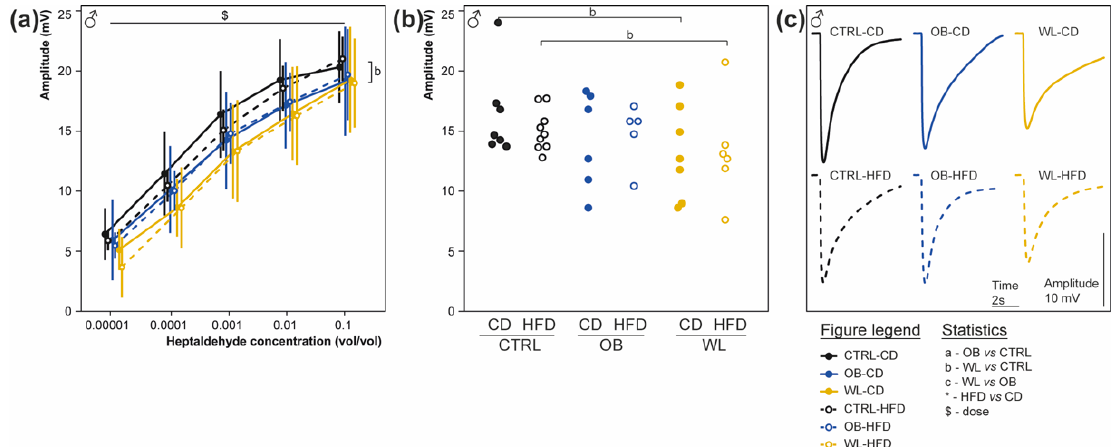
Figure 6. Weight loss decreases the electrical response of the olfactory epithelium to heptaldehyde in male. Electroolfactograms (EOG) recordings were obtained from olfactory epithelium (OE) from male mice at sacrifice at 6 months, after 23 – 25 weeks of post-weaning diet. The amplitudes of the EOG responses after successive application of increasing concentrations of HEP on both OE turbinates IIb and III are represented as mean ± SD for male mice ( a : CTRL-CD, n = 7; CTRL-HFD, n = 9; OB-CD, n = 6, OB-HFD, n = 5, WL-CD, n = 7 and WL-HFD, n = 6). Scatterplot representation ( b ) and typical trace ( c ) of EOG responses to heptaldehyde at 1:1000 in mineral oil are given for the 6 groups.